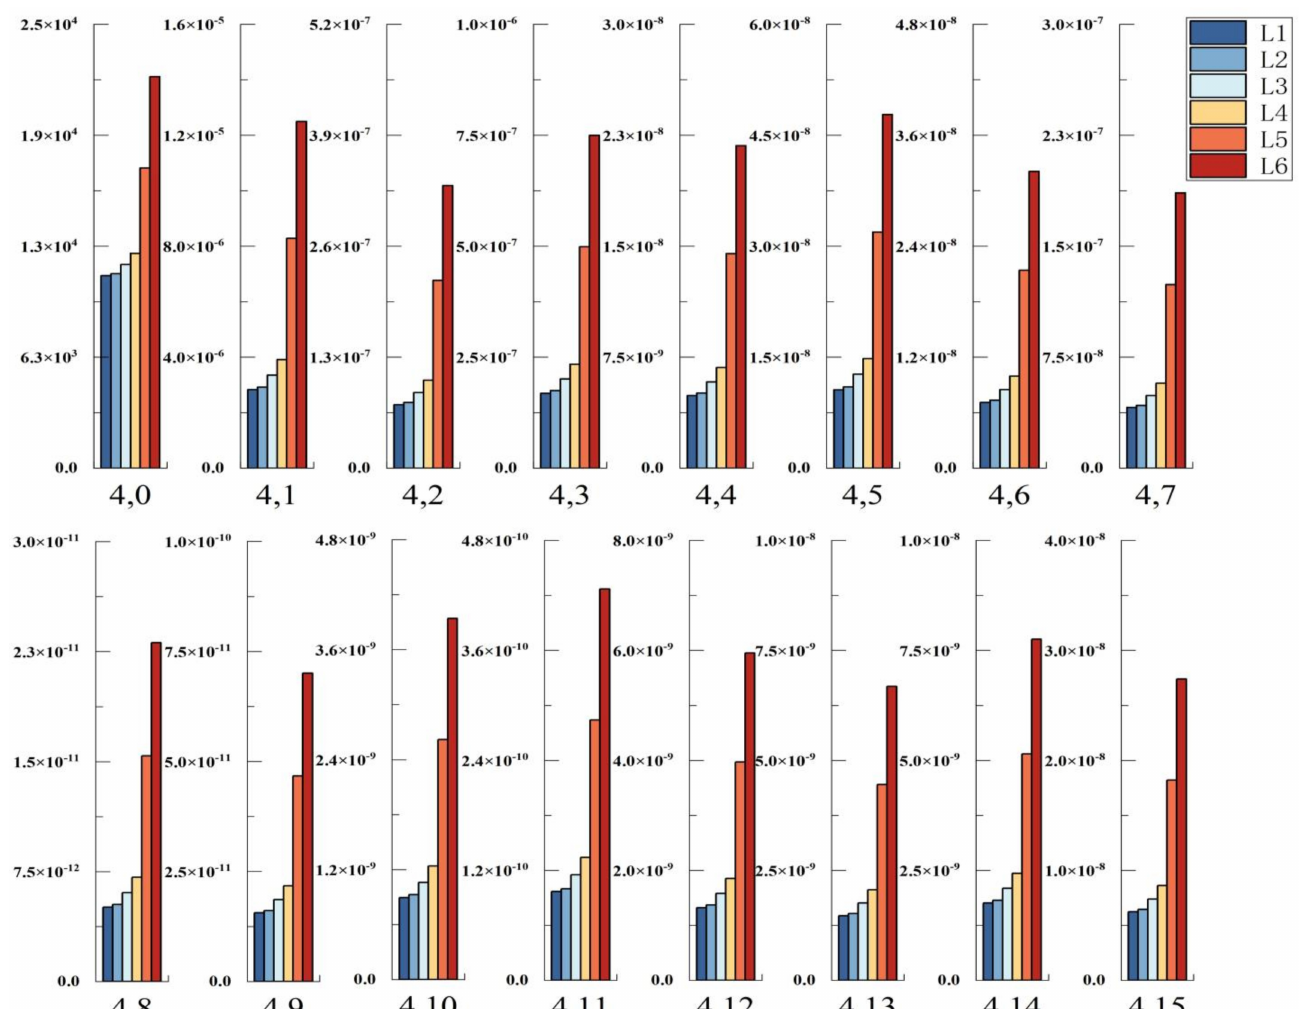
Figure 26. Characteristic energy of wavelet packet of piston rod side pressure when hydraulic cylinder